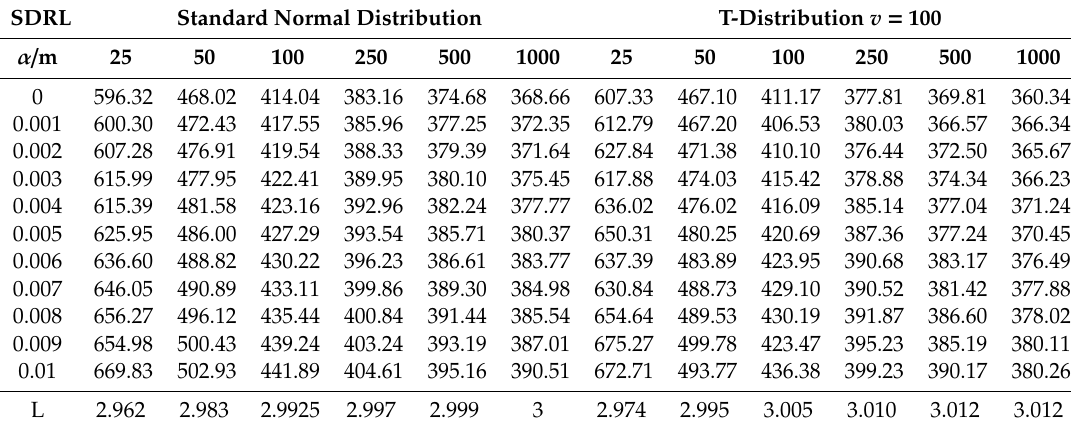
Table 6. SDRL of the Shewhart chart with Tukey outlier detection for standard normal and t ( v = 100) distributions.